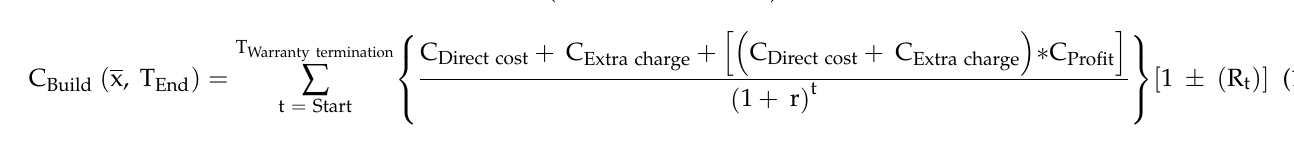
Table 2. Budget process of project. Unit: